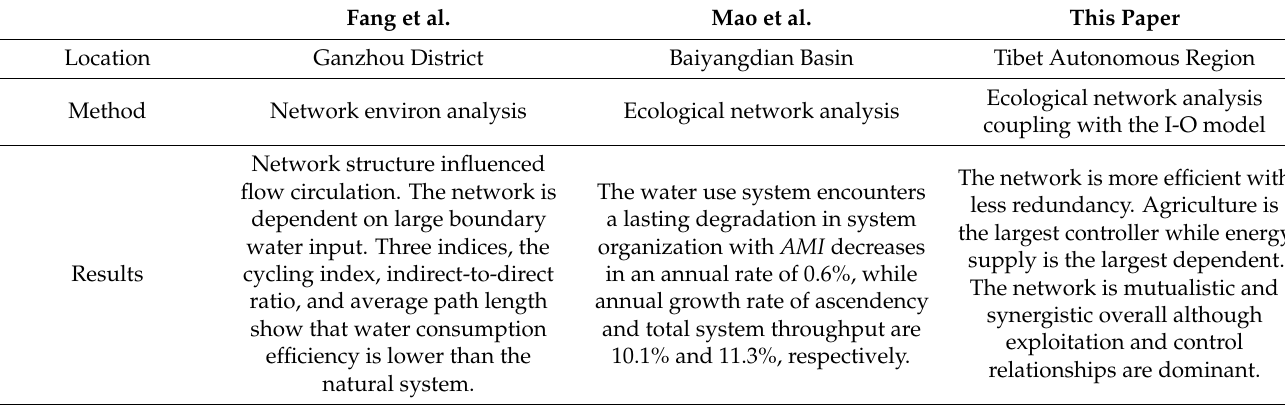
Table 1. Comparison of related